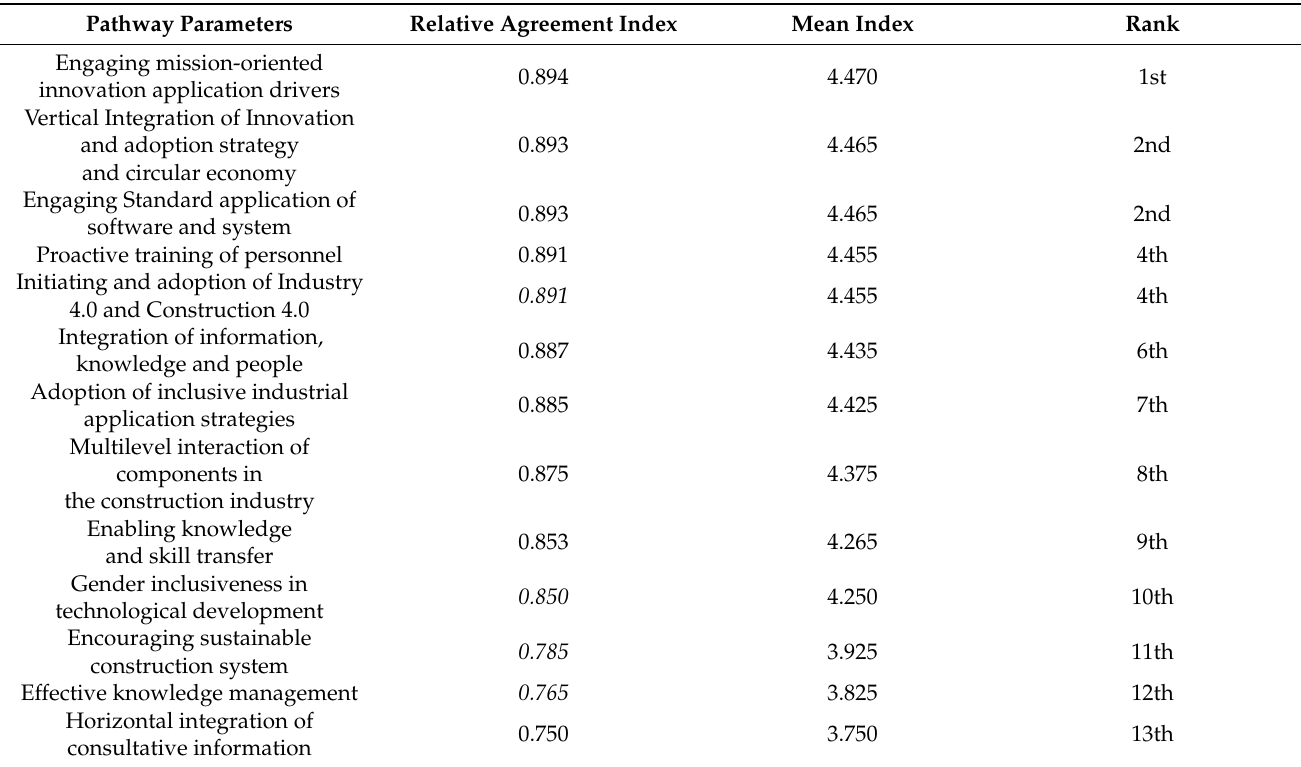
Table 16. Pathways of achieving Sustainable Innovations and Inclusive Technological Development Pathway